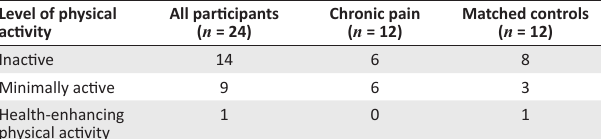
TABLE 3: Frequency table for levels of physical activity on the IPAQ ( N =